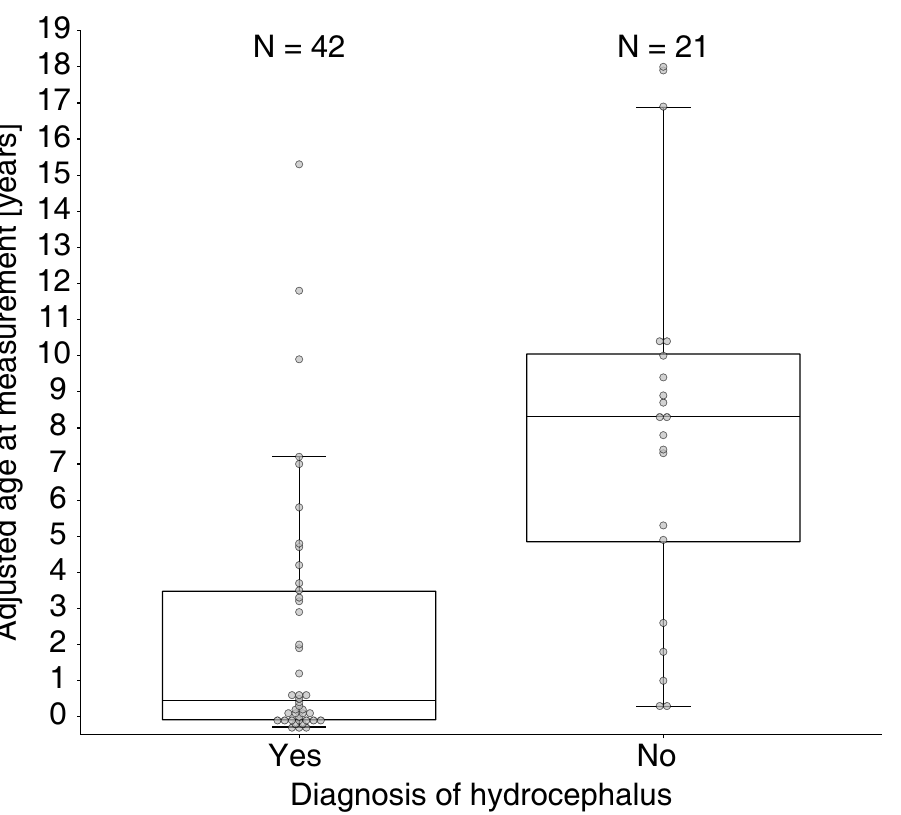
Fig 5. Age at measurement (in years) among the 63 CSF samples from patients diagnosed with or without hydrocephalus.